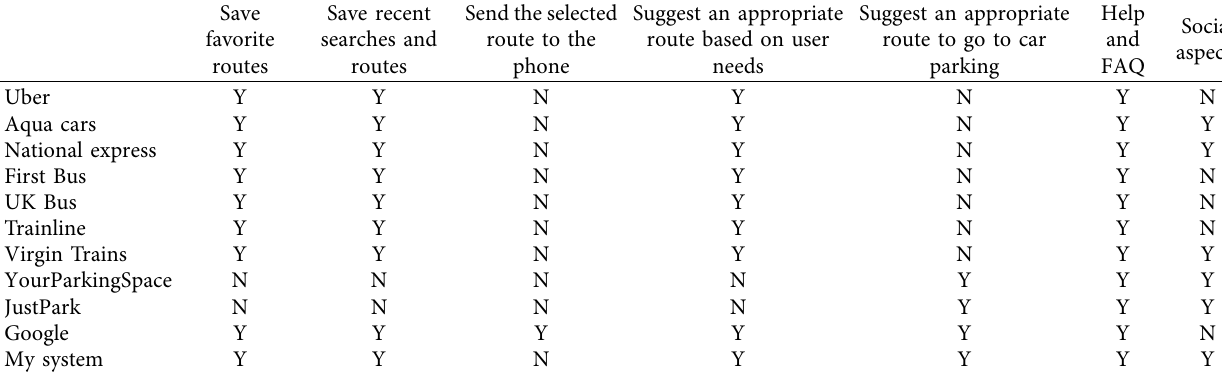
Table 2: Usability of diverse public transportation apps.